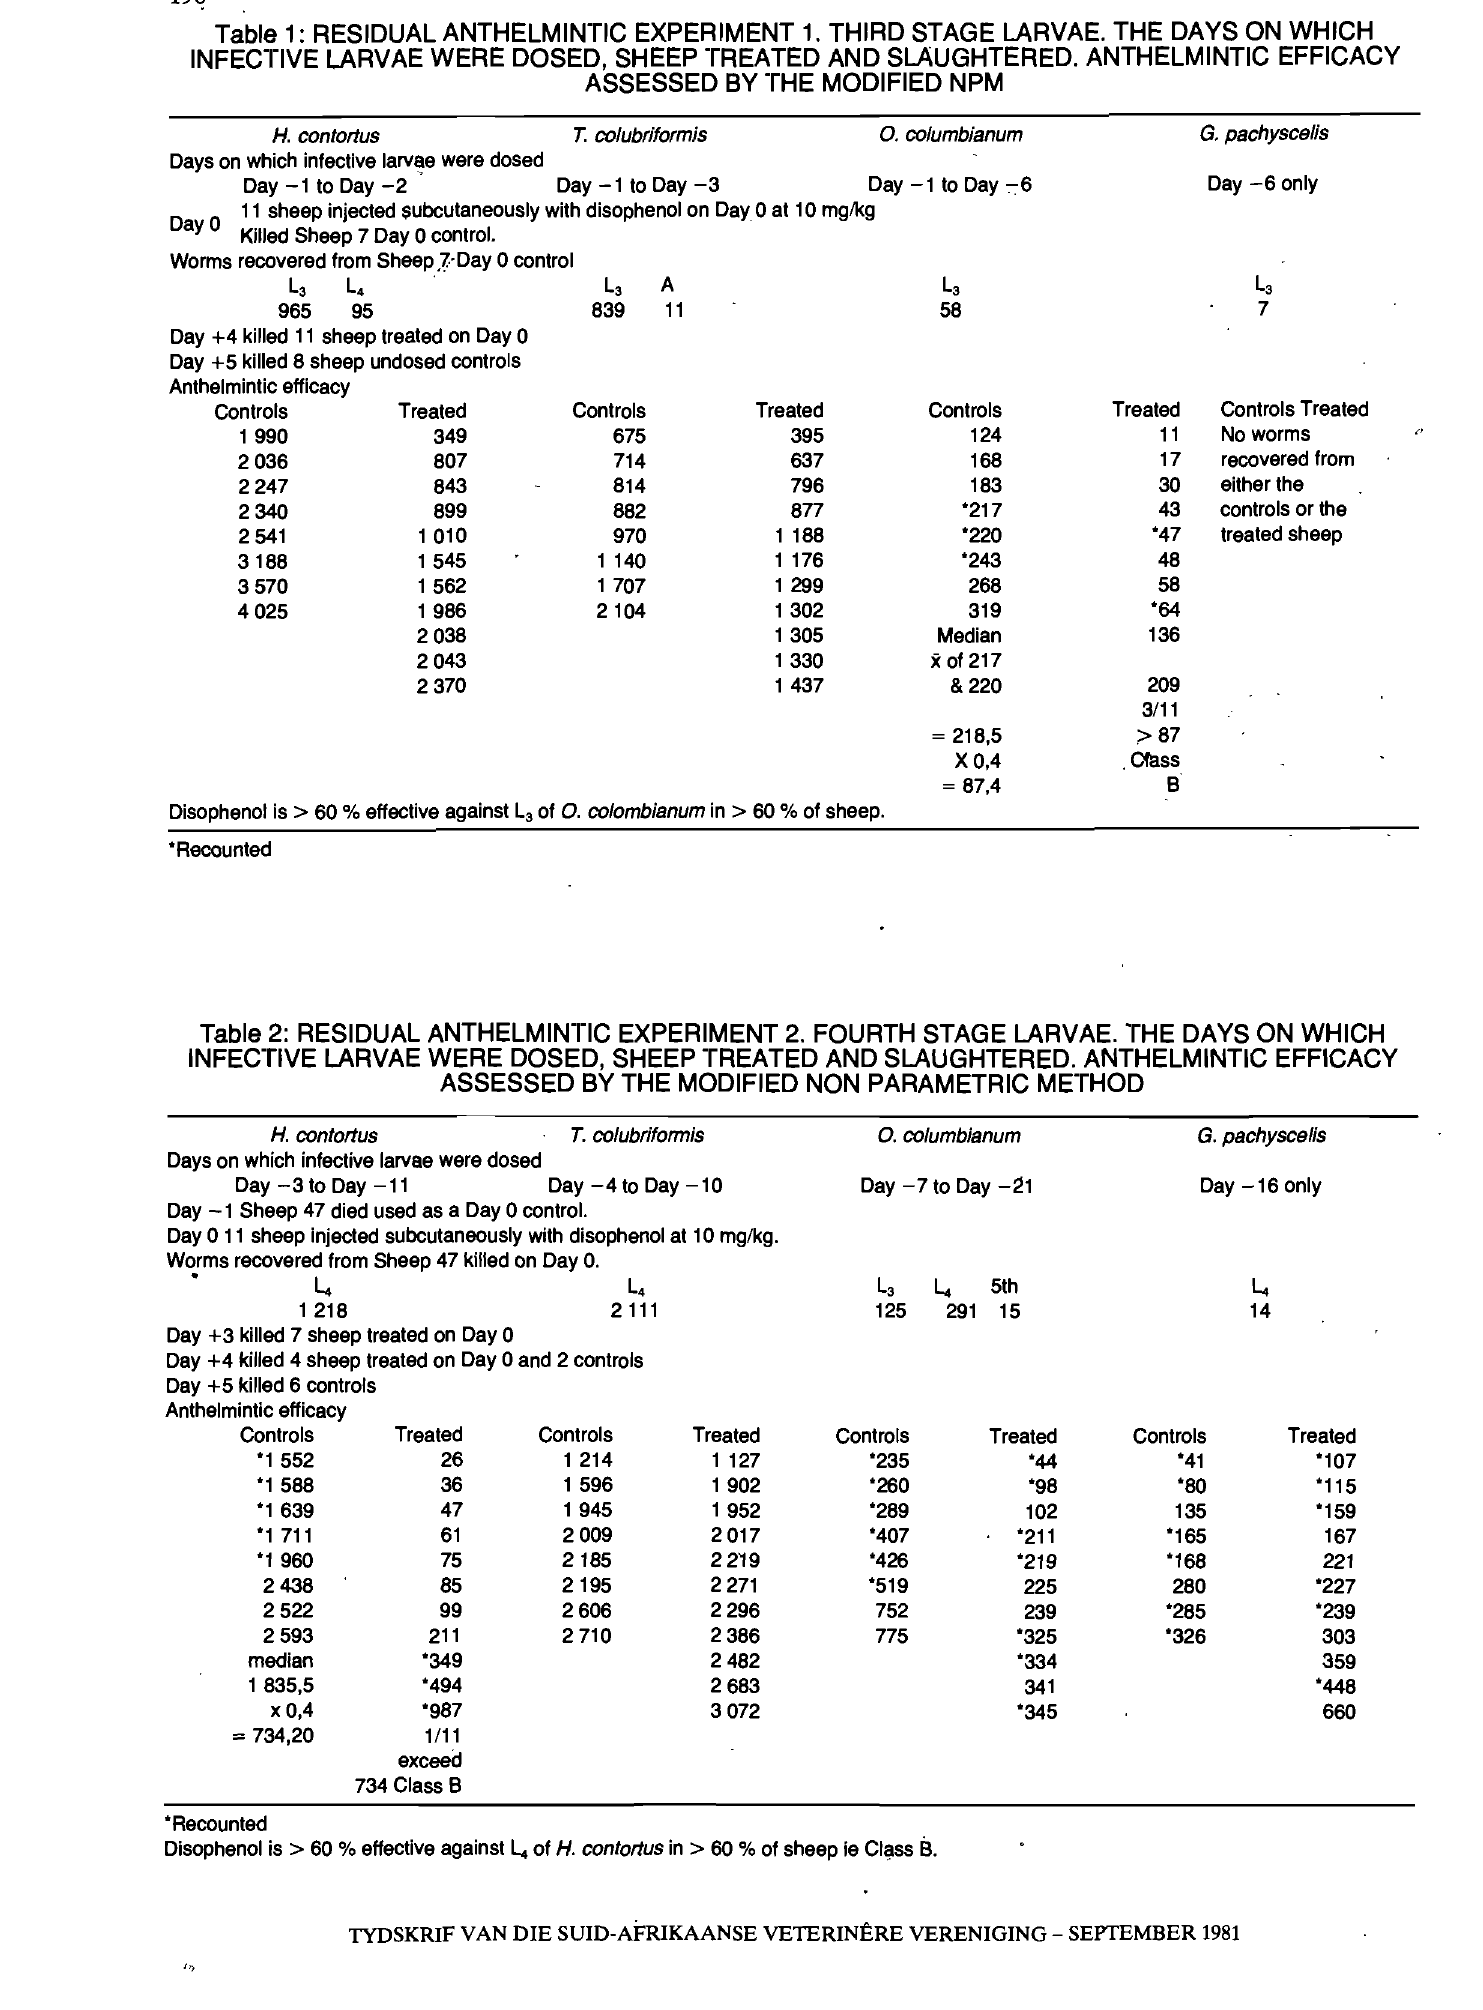
Table 1: RESIDUAL ANTHELMINTIC EXPERIMENT 1. THIRD STAGE LARVAE. THE DAYS ON WHICH INFECTIVE LARVAE WERE DOSED, SHEEP TREATED AND SLAUGHTERED. ANTHELMINTIC EFFICACY ASSESSED BY THE MODIFIED NPM H. con/ortus